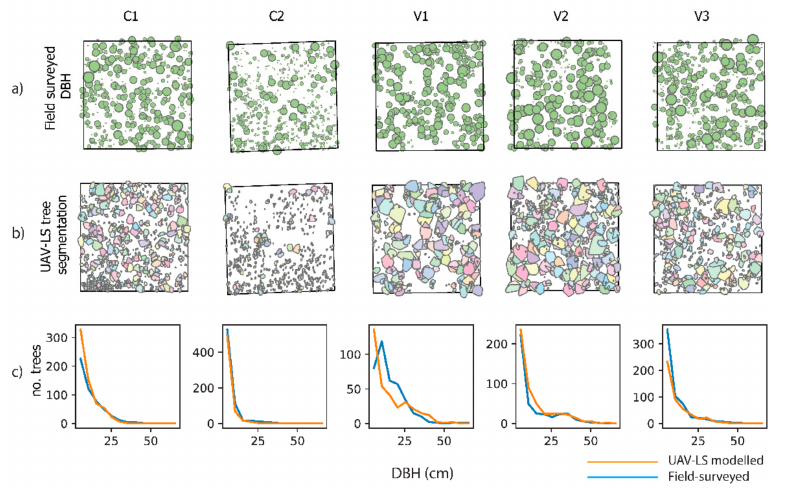
Figure 6. Plot level figures showing maps of ( a ) Field census survey, with points sized according to DBH ( b ) crown polygons fitted to point cloud segmentation with the AMS3D algorithm. ( c ) displays the diameter distribution of field-surveyed and UAV-LS modelled DBH, derived from polygons using the LOESS crown diameter allometry. The number of trees was calculated using 5 cm DBH bin sizes, and all data below 3 cm DBH was removed from both datasets to allow comparisons between field-surveyed and UAV-LS diameter